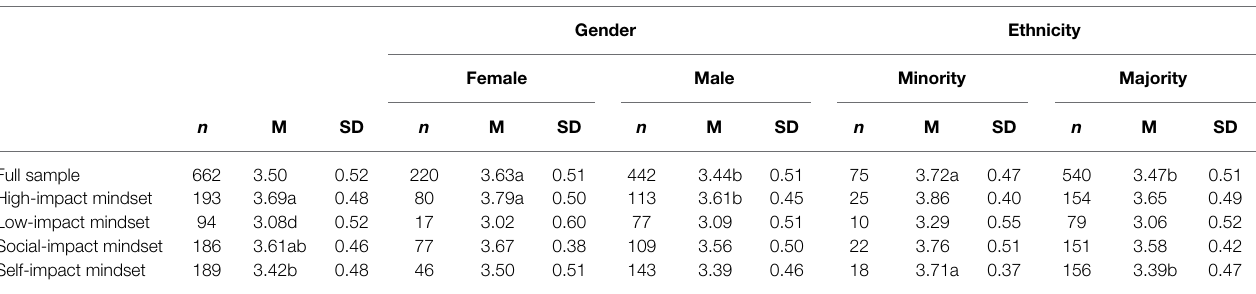
TABLE 4 | Mean-level analysis study